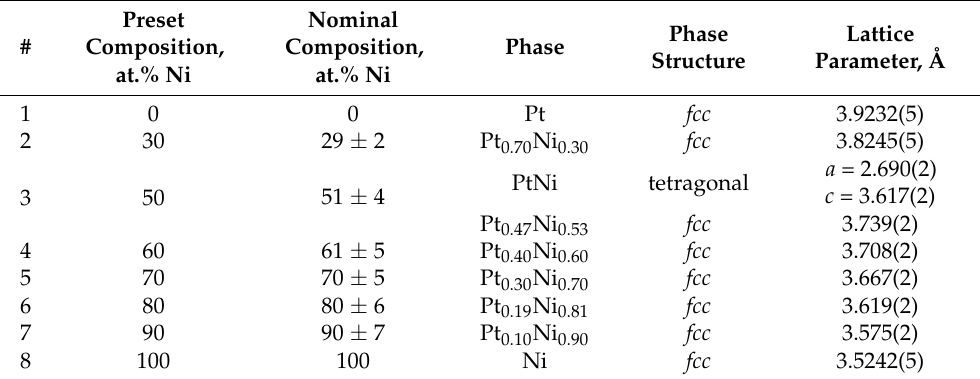
Table 1. Chemical composition and crystallographic characteristics of synthesized Pt 1 − x Ni x (x = 0.0– 1.0) alloys.